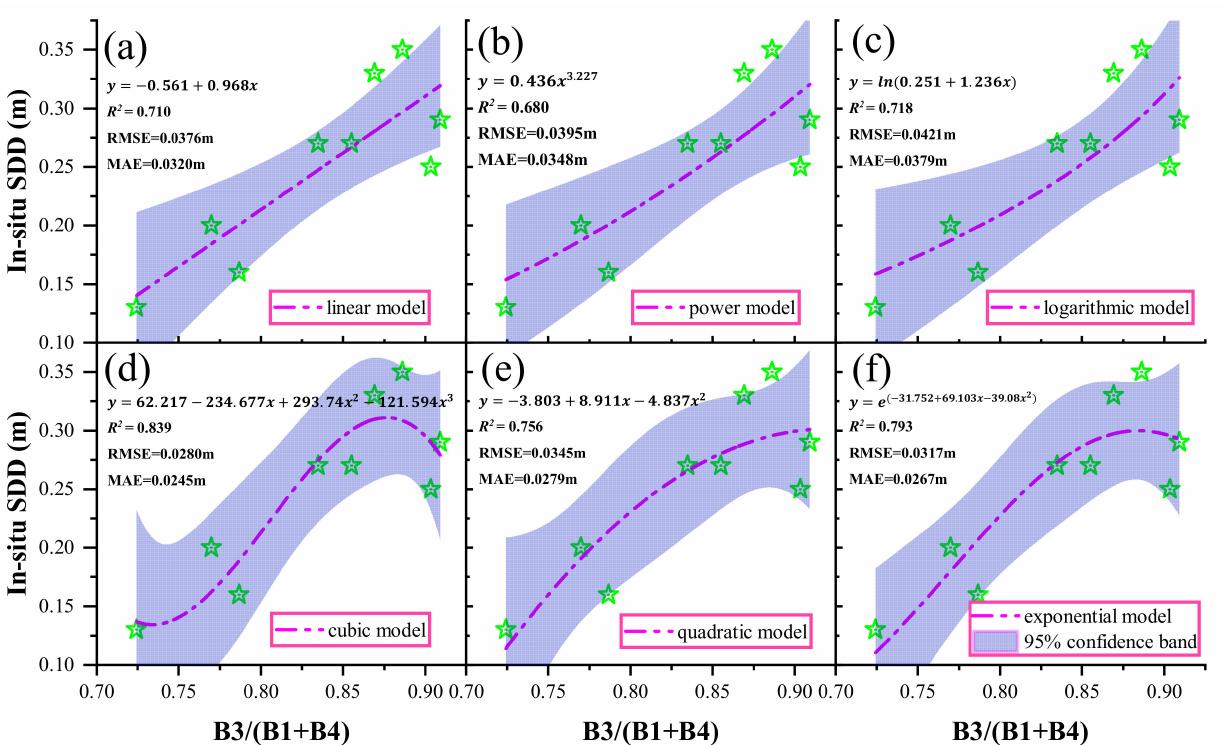
Figure 3. Six regression models were developed between in-situ SDD and B3/(B1 + B4), including ( a ) linear; ( b ) power; ( c ) logarithmic; ( d ) cubic; ( e ) quadratic; ( f ) exponential. The universal kriging interpolation algorithm (Gaussian function as the variogram model) was used to spatially interpolate the in-situ sample points, which is a common method for overcoming the disadvantages of small samples [48,49]. A 100-m buffer zone was created on either side of the in-situ sample points in order to increase the confidence of the samples, and 100 sample points were randomly selected within the buffer zone (see Figure 2c). We set the interpolated values of the kriging algorithm as the true values (i.e., measured SDD) and the calculated values of the six models as the predicted values (i.e., predicted SDD) (Figure 4). The results showed that the cubic model had the smallest R-value and the largest RMSE and MAE values, indicating the high sensitivity and poor stability of the cubic model. The results of the validation of the quadratic and logarithmic models were similar, with R values of 0.5499 and 0.5550, RMSE values of 0.0848 m and 0.1524 m, and MAE values of 0.0072 m and 0.0232 m, respectively. The R values of the linear, power, and exponential models were greater than 0.65. The exponential model had the smallest RMSE and MAE values of 0.0556 m and 0.0030 m. Thus, we used the exponential model (i.e., y = e ( − 31.752 + 69.103 x − 39.08 x 2 ) ), x denotes the value of red/(blue-near-infrared)) to inverse the values of SDD in the study